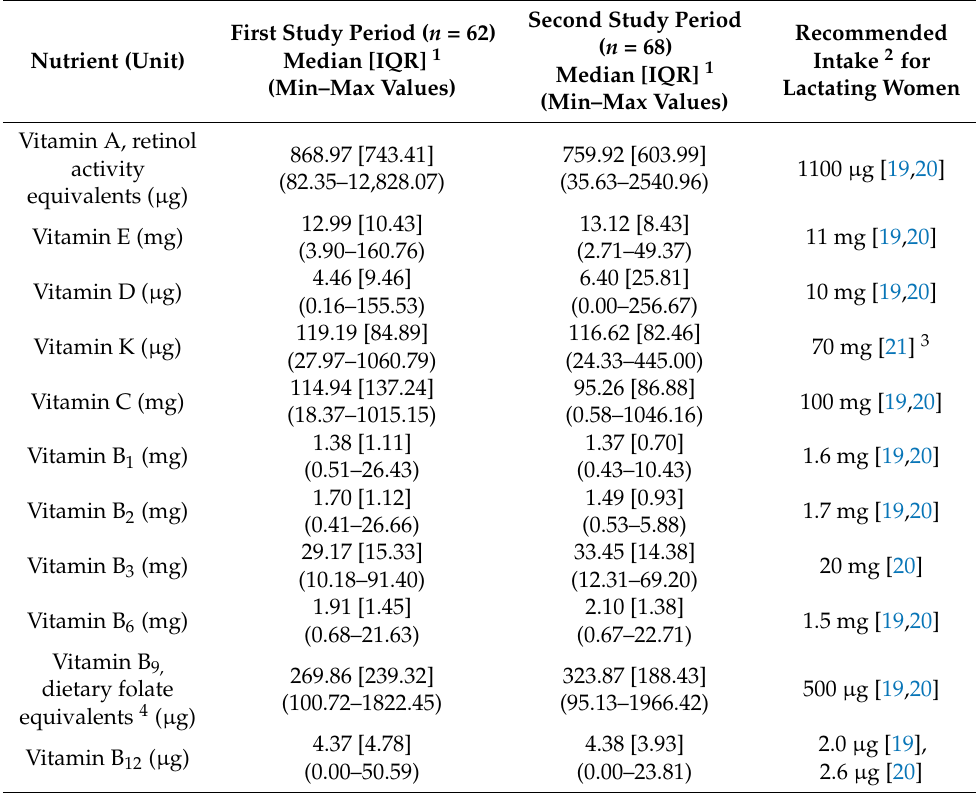
Table 4. Vitamin intakes among the participants ( n =